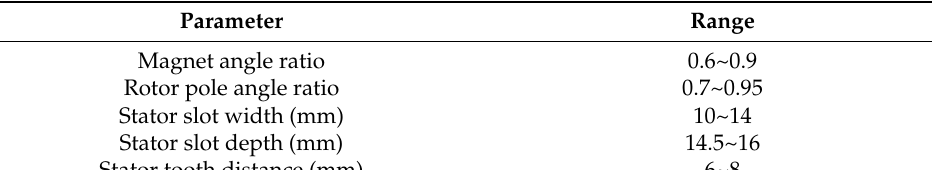
Figure 9 is chosen as the final optimization result compared with all the optimal solutions.